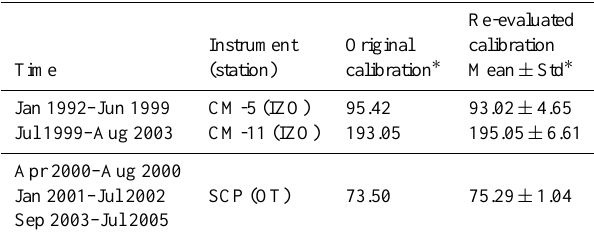
Table 2. Calibration of the different pyranometers installed at IZO and OT between 1992 and 2005 ( ∗ : Wm − 2 /mV).